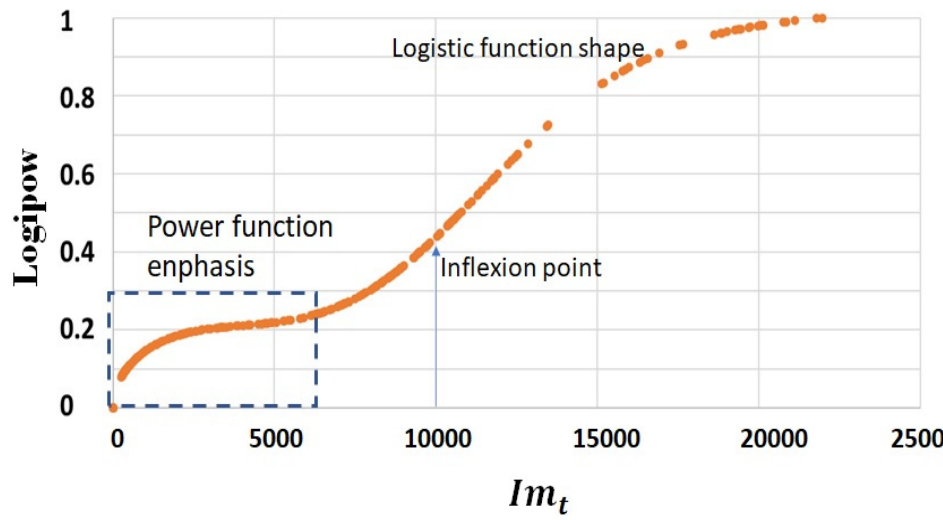
Figure A4. A sample of the Logipow function molded by parameters.